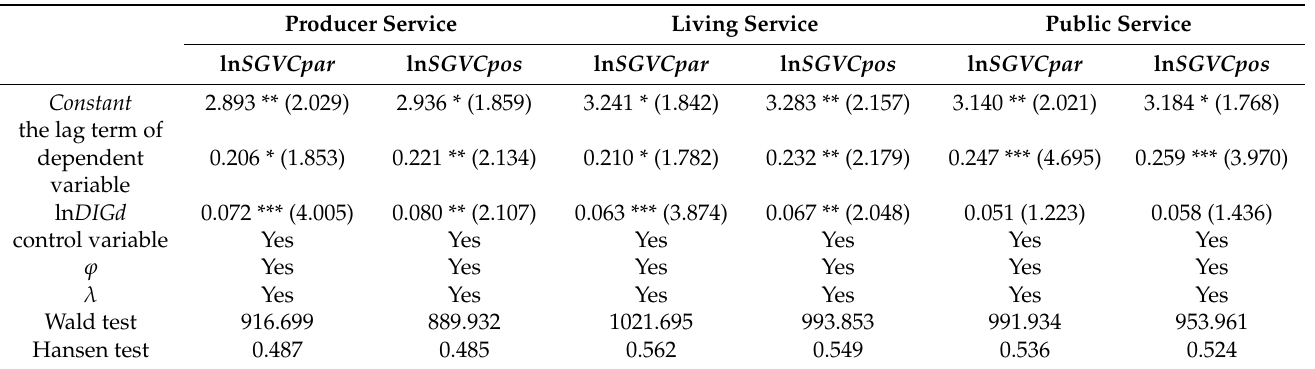
Table 5. Results of heterogeneity test